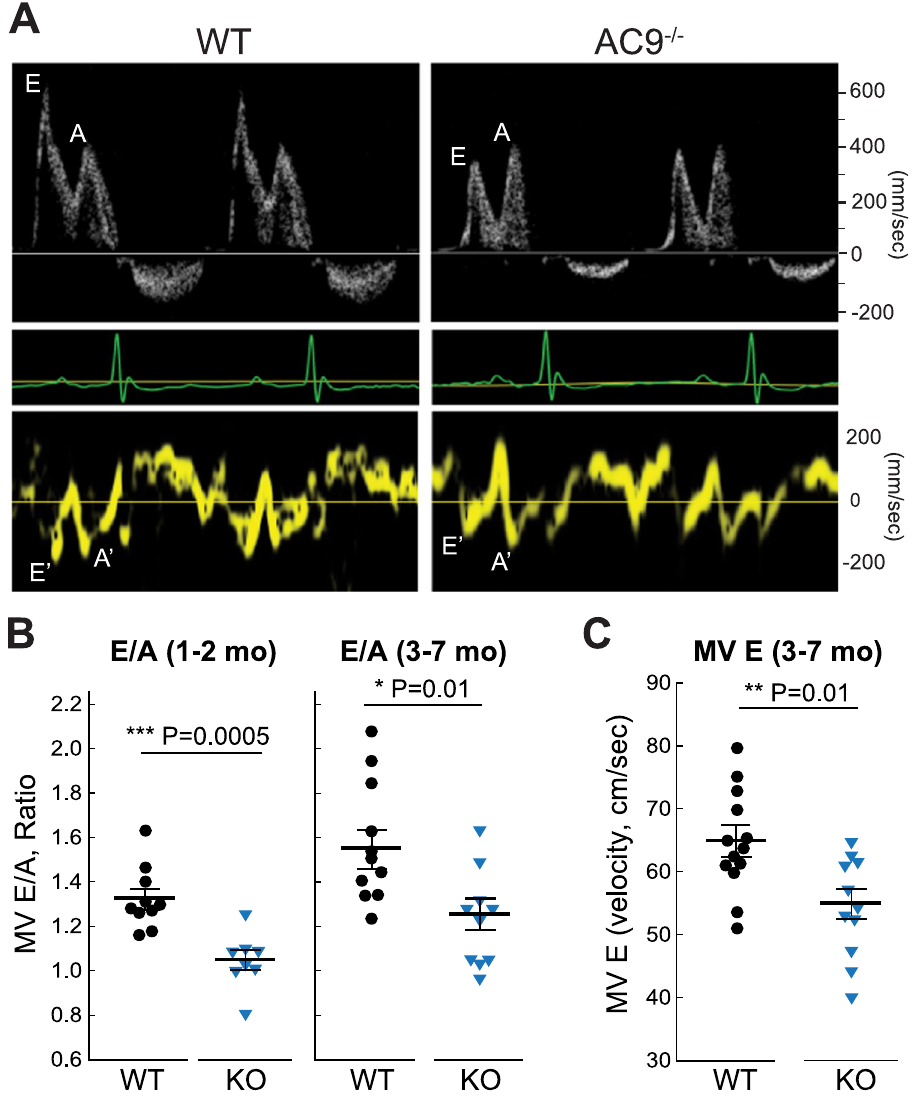
Figure 6. Cardiac parameters for WT and AC9 − / − mice. ( A ) Pulsed-wave and tissue Doppler recordings for female WT and AC9 − / − littermates (3 month) showing the relative amplitudes of the early ventricular filling (E wave) and the late filling caused by atrial contraction (A wave) (ECGs are shown below for each animal). ( B ) Quantitation of E/A ratio at 1–2 (n = 10 WT and 8 AC9 − / − ; males, P = 0.0005) or 3–7 months (n = 11 WT and 11 AC9 − / − ; males and females, P = 0.005). ( C ) Quantitation of mitral valve E wave at 3–7 months (n = 13 WT and 11 AC9 − / − , P = 0.005). Mean + / −